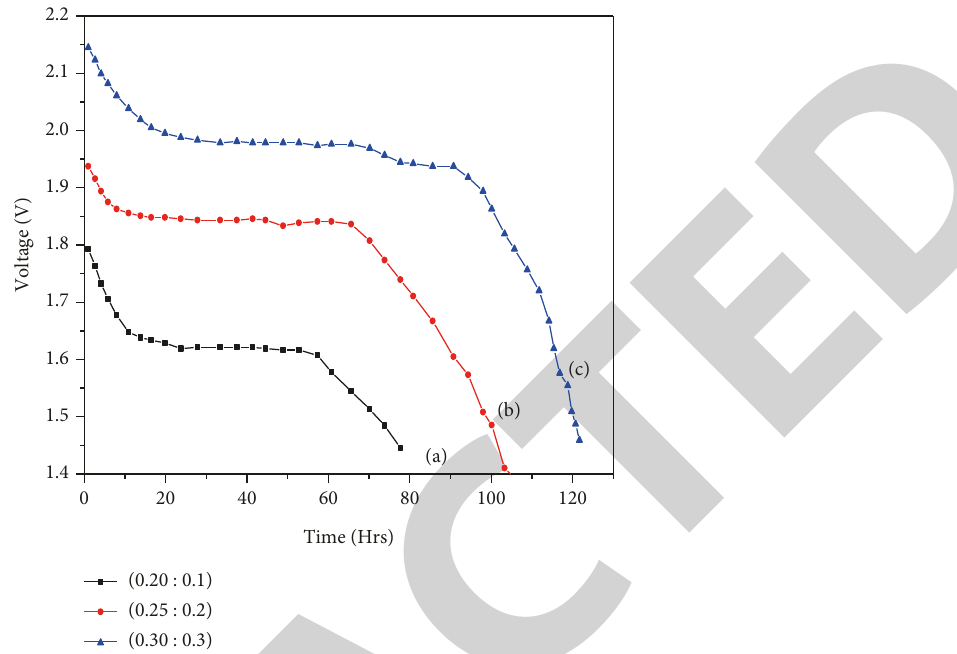
Figure 11: Discharge characteristics of polymer electrolyte films for different PVP/PVA : GO wt.% ratios of (0.20 : 0.1), (0.25 : 0.2), and (0.30 :